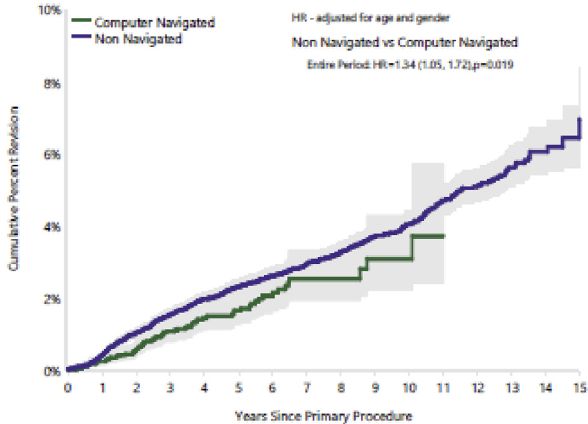
Figure 3. Australian Joint registry report